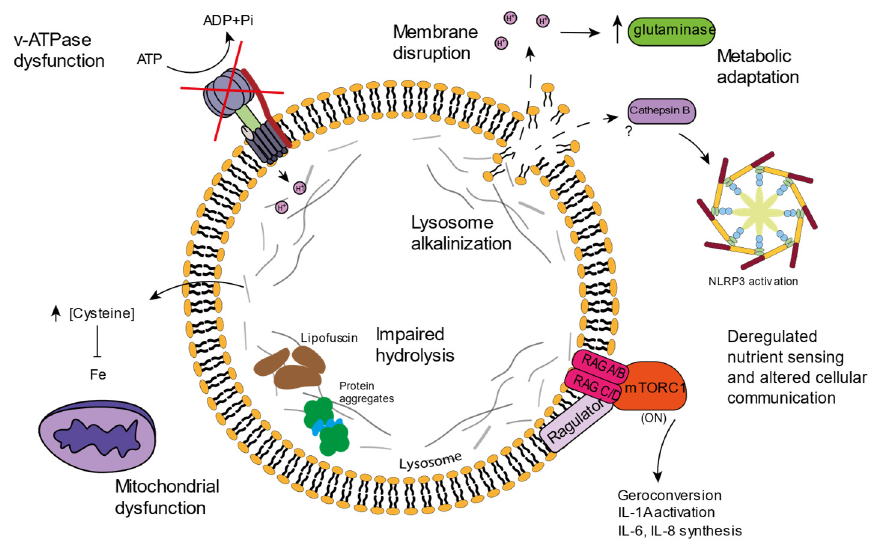
Figure 2. An overview of the lysosomal dysfunctions associated with aging or senescence. v-ATPase dysfunctions and membrane disruption impair the lysosomal acidification process, which shows increased alkalinization. Protons escaping the lysosome provoke cytosolic acidification, which alters cellular metabolism, and the presence of cathepsin B has been linked to NLRP3 inflammasome activation. Impaired hydrolysis inside the lysosome results in protein aggregation and lipofuscin storage. Incorrect amino acid storage is linked to mitochondrial dysfunction, and mTORC1 activation in the lysosome surface correlates with the synthesis of SASP molecules and geroconversion.